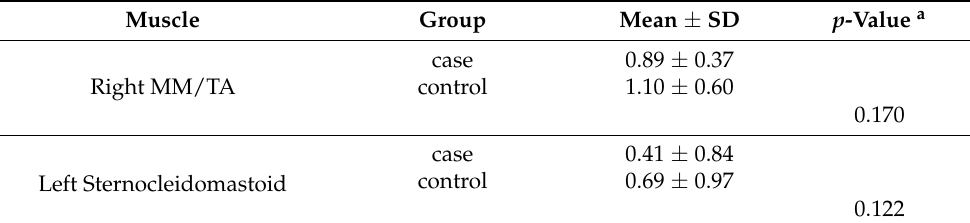
Table 3. Head and neck electromyographic analysis (Mann–Whitney U test). Mean and standard deviation values of right and left masseter/temporal ratios (MM/TA) in case and control groups.